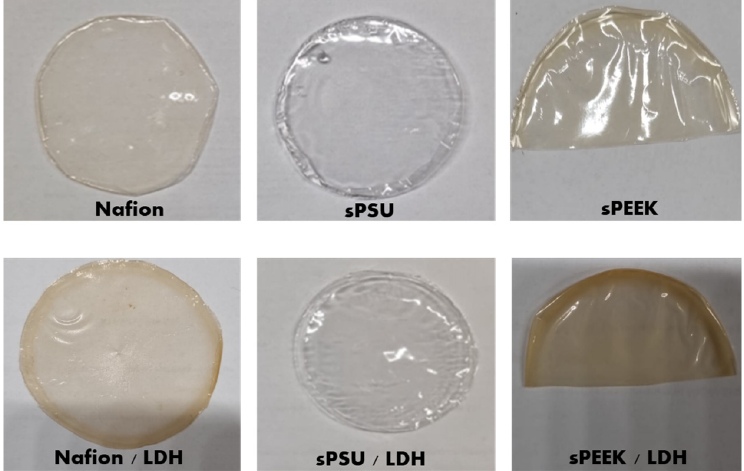
Figure 1. Pictures of Nafion, sPSU, and sPEEk-LDH composites (at 3% of filler loading) membranes.